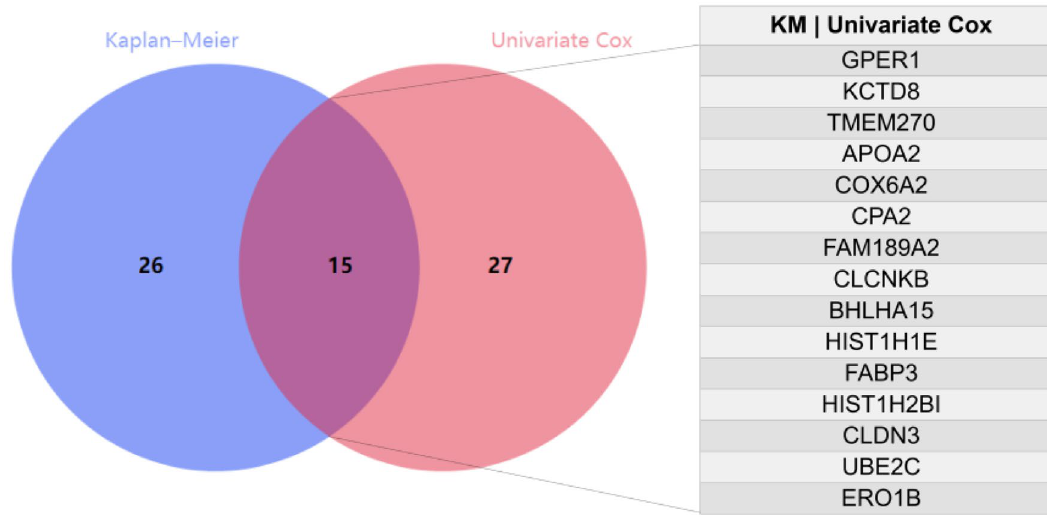
Figure 4. Venn diagrams for screening prognostic genes of the EC by Kaplan–Meier (KM) and univariate Cox analysis. A total of 15 common prognostic related genes (GPER1,KCTD8,TMEM270,APOA2,COX6A2,CPA2,F